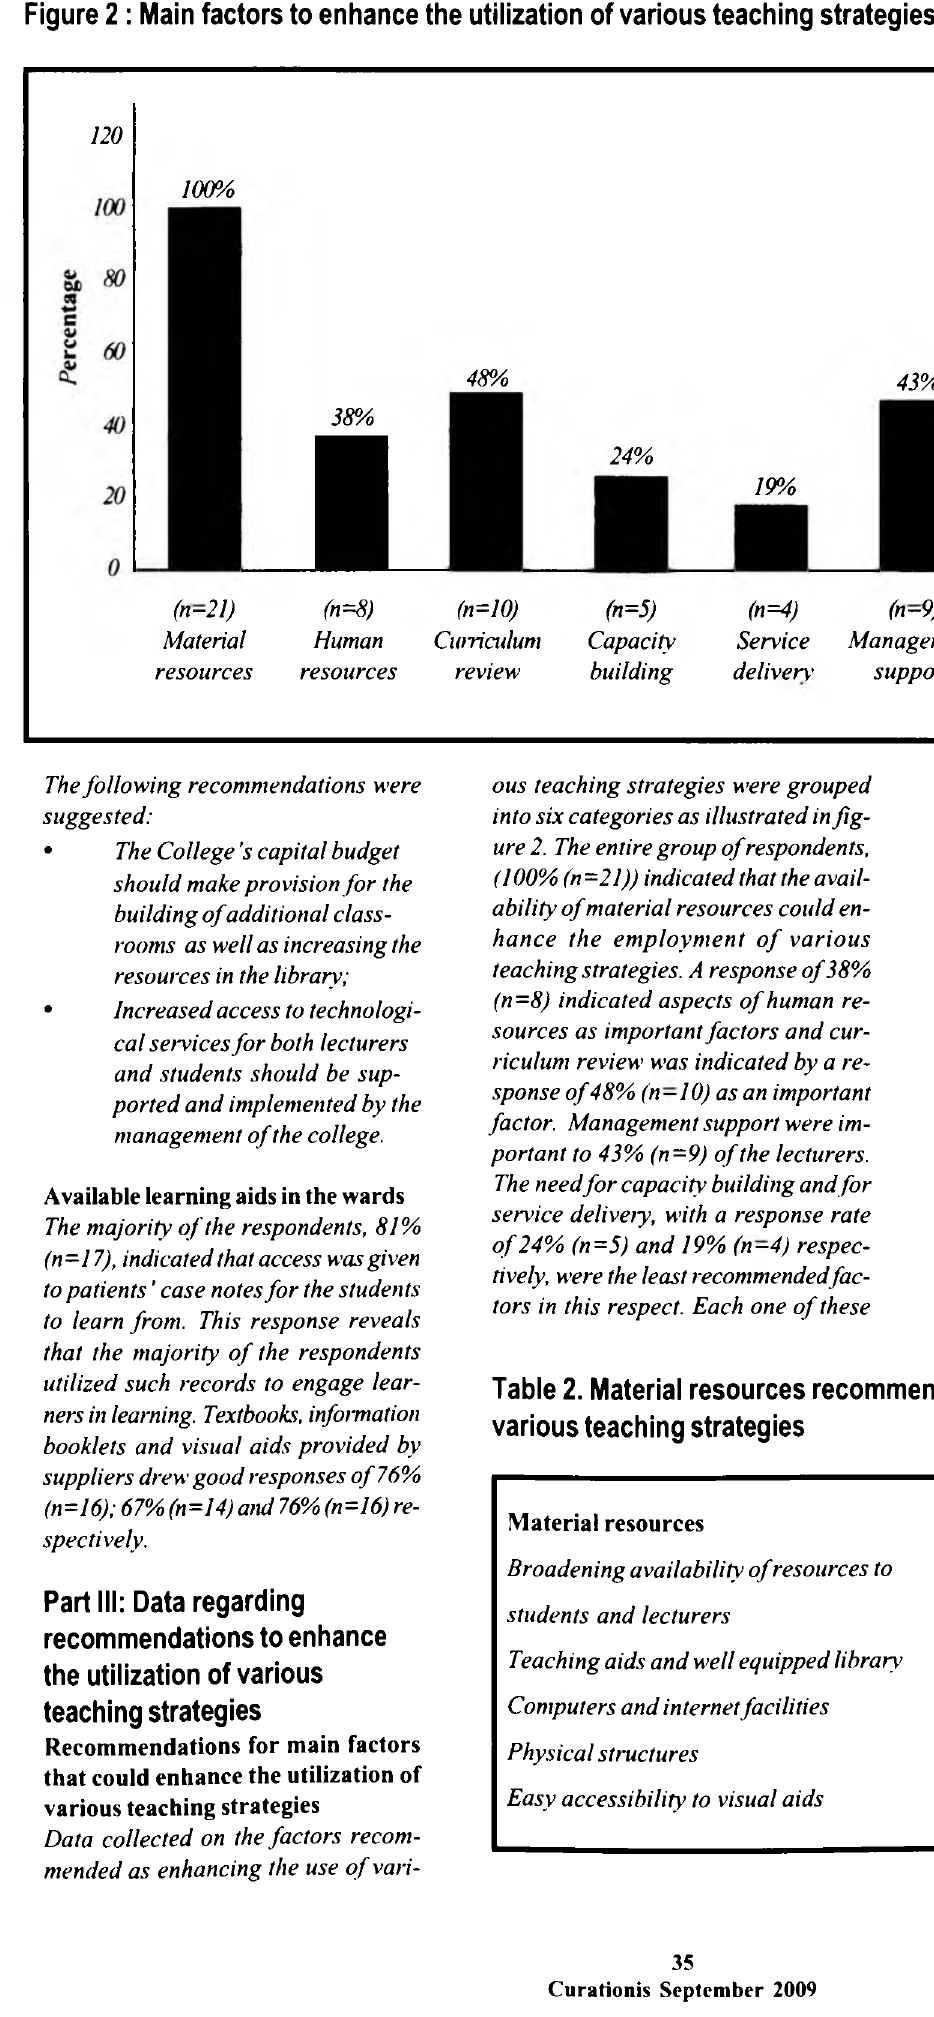
Figure 2: Main factors to enhance the utilization of various teaching strategies factors will be analyzed